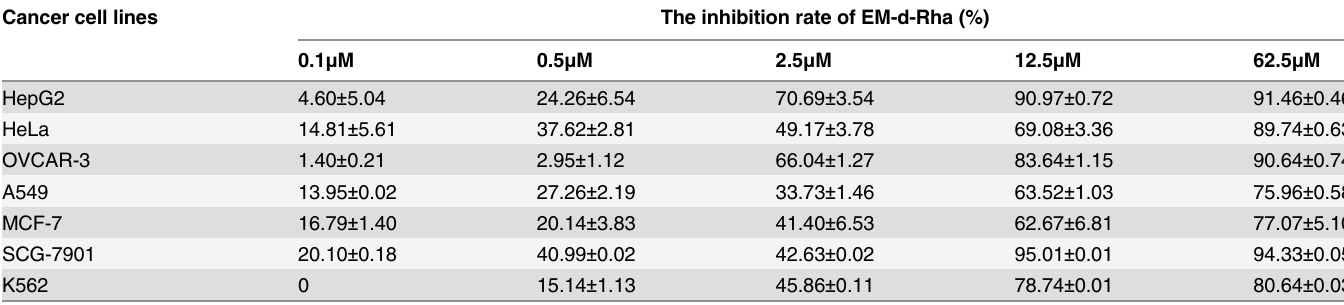
Table 3. Inhibition rate of EM-d-Rha against various cancer cells lines. Cancer cell